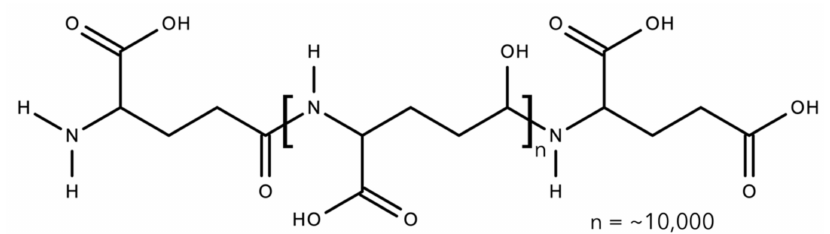
Figure 17. Molecular structure of γ -PGA (note the n number and similarity to